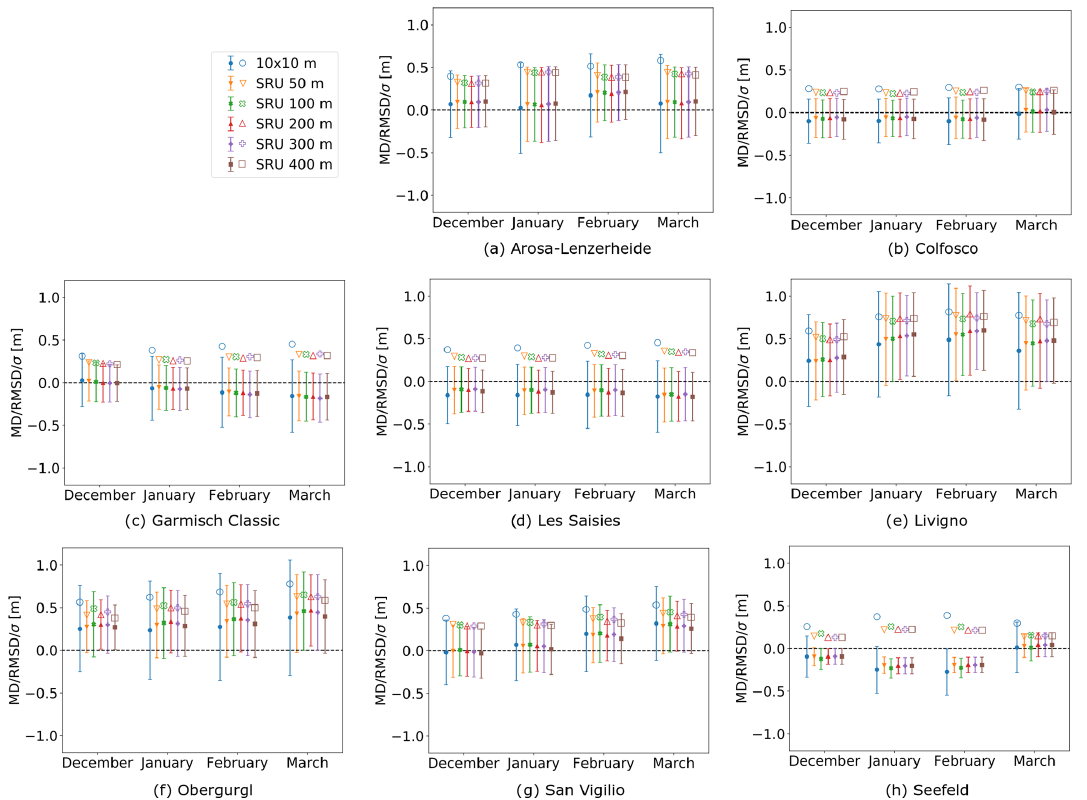
Figure 6. Overview of the root mean square deviation (RMSD; hollow symbols), mean deviation (MD; filled symbols), and standard deviation ( σ ; extent of error bars) between simulated and GNSS-measured snow depth considering all the time steps and displayed for each different SRU resolution for the entire ski resort. The presented data are analyzed for the 4 months December, January, February, and March, when GNSS data were